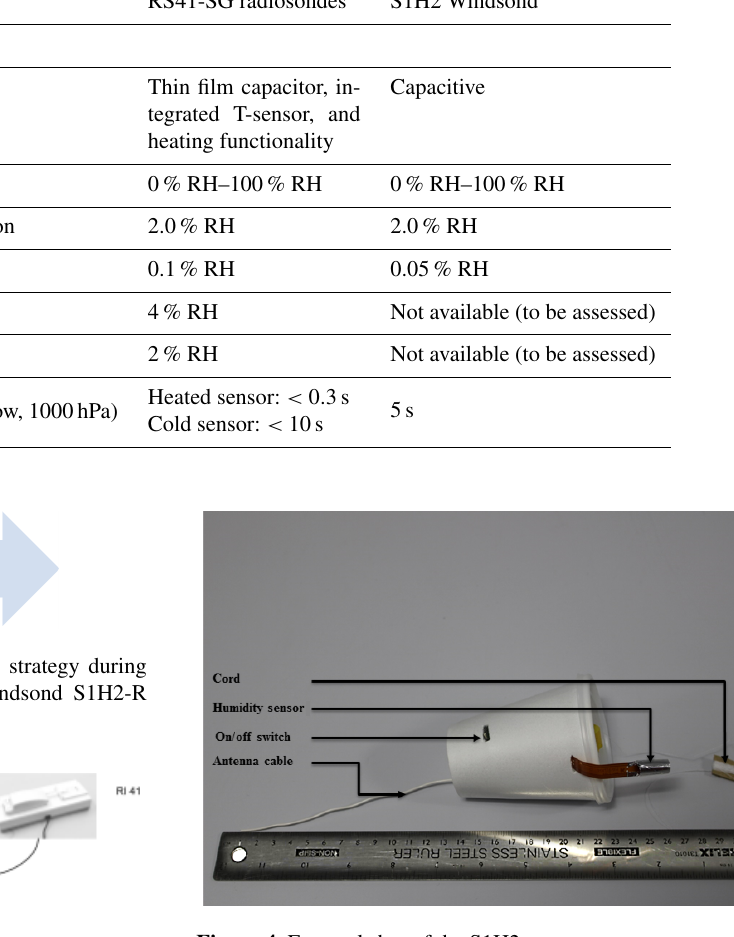
Figure 4. External shot of the